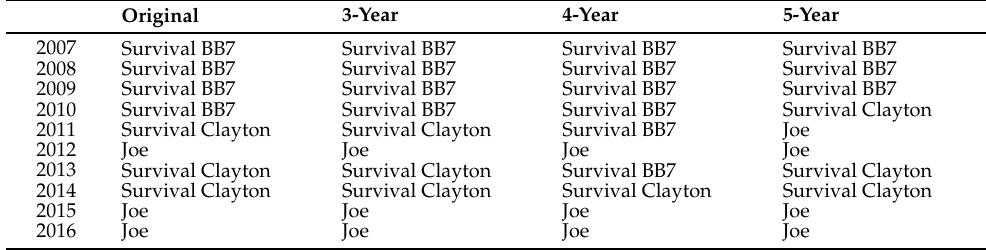
Table 8. The selected optimal copula estimation between RCI and carbon efficiency for each year from 2007 to 2016.